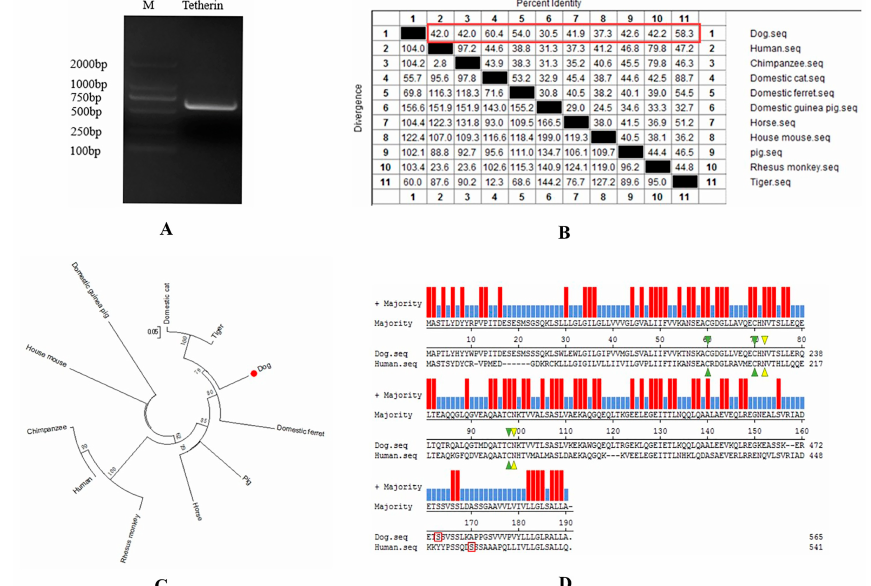
Figure 1. Bioinformatic analysis of the canine tetherin gene sequence. ( A ) Amplification of the canine tetherin gene by RT-PCR. M: DL2000 DNA Marker; ( B ) comparison of amino acid homology; ( C ) phylogenetic tree analysis of the tetherin gene; ( D ) comparison of the sequences of canine tetherin and human tetherin. Red represents amino acid homology. Blue represents amino acid inconsistency. Green triangles represent cysteine residues. Yellow triangles represent glycosylation sites. The red box represents the GPI anchor